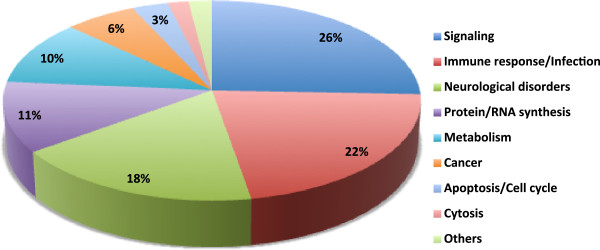
Representation of statistically significant enriched pathways of PBMC mRNA profiles. Pie chart representing pathway analysis. Each part of the pie chart represents -log2 of the P-value of pathway from the set of significant pathways, where the total of -log2 of the P-value is 1. The P-values were retrieved from the pathway analysis in WebGestalt.